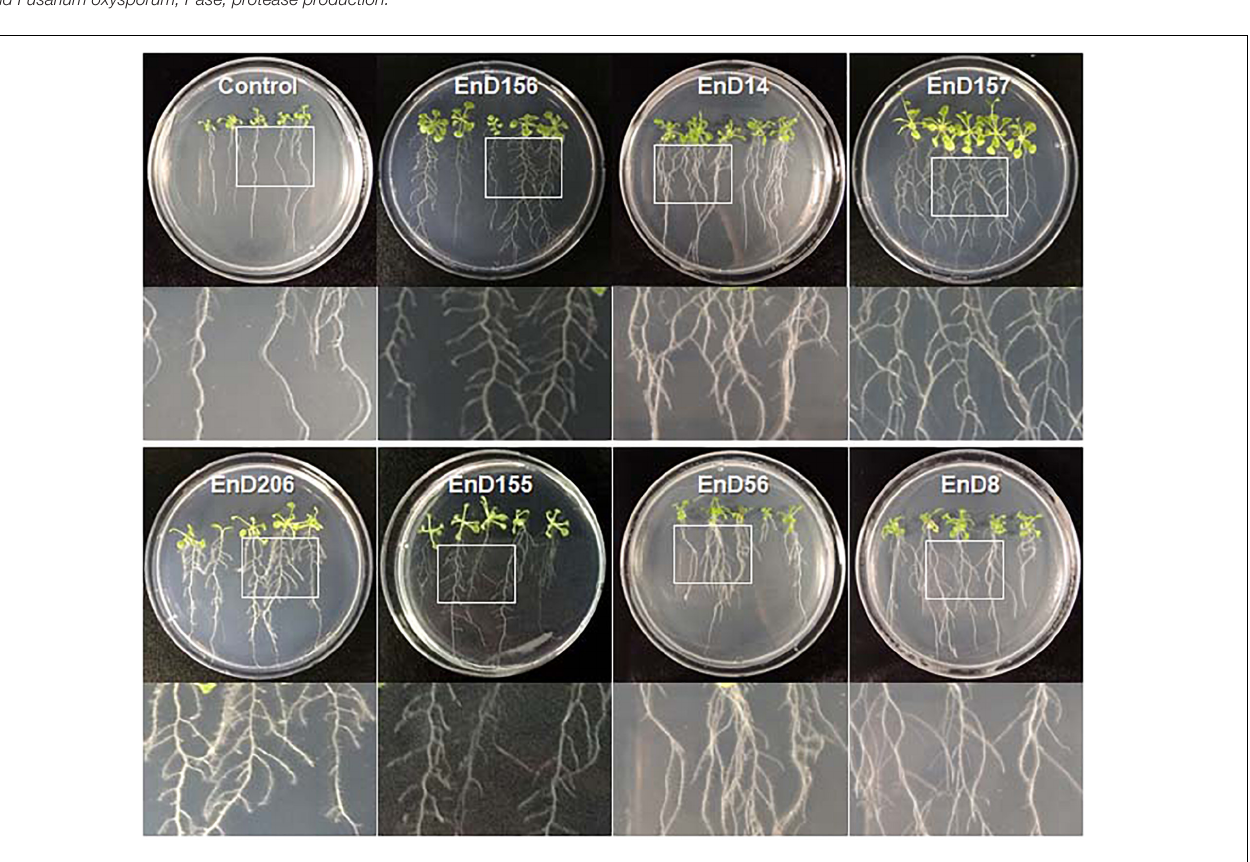
FIGURE 6 | Growth promotion of Arabidopsis by treatment of bacterial cells isolated from rhizosphere and endophytic bacteria in long-sepal Donggang pasque-flower plants. A. thaliana ecotype Col-0 seeds were surface sterilized and bacterized by soaking in each bacterial suspension. The bacterized seeds were sown onto 1/2 MS medium and cultured in plant-growth chambers. The photographs shown were acquired 10 days after incubation. Refer to Table 1 for the scientific names of each